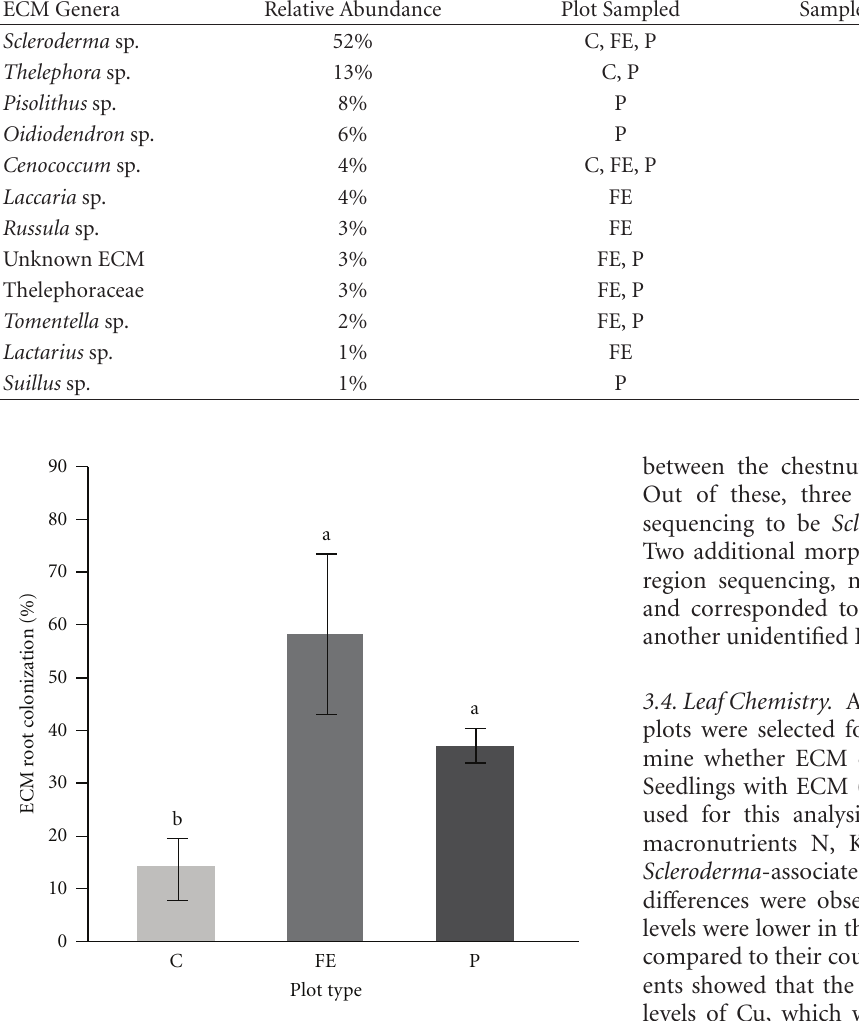
Figure 3: Percent ECM root tips ( ± 1 SE) on American chestnut seedlings after two field seasons. Bars sharing common letters do not significantly di ff er at α = 0 . 05 determined by Tukey’s HSD. Seedlings in the center plots (C) had less ECM on roots when compared to forest edge (FE) and pine plots